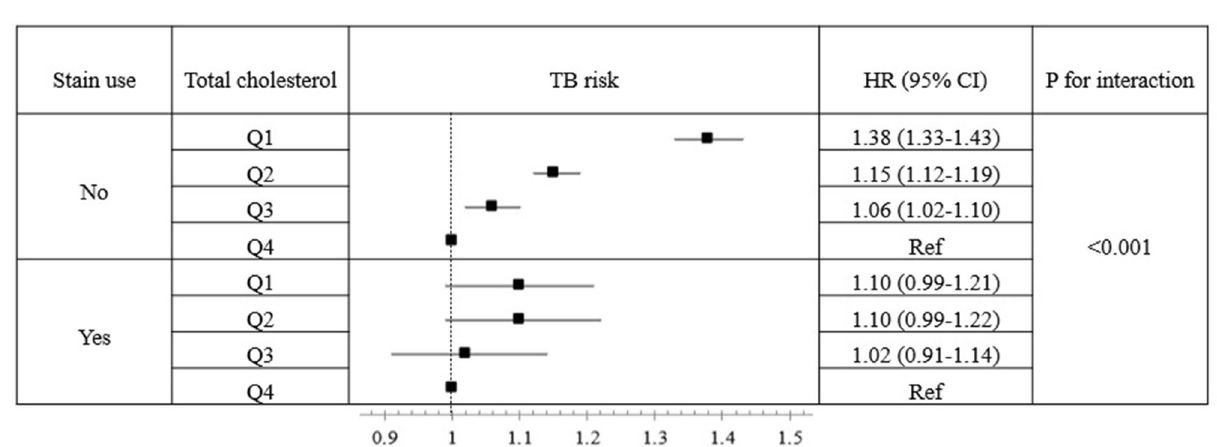
Figure 1. TB risk by quartile of total cholesterol level stratified by statin use. Age, sex, smoking status, drinking habits, physical activity, BMI, diabetes mellitus, asthma or COPD, and GFR were adjusted. TB tuberculosis, HR hazard ratio, CI confidence interval, Q1 the lowest quartile, Q4 the highest quartile, BMI body mass index, COPD chronic obstructive pulmonary disease, GFR glomerular filtration